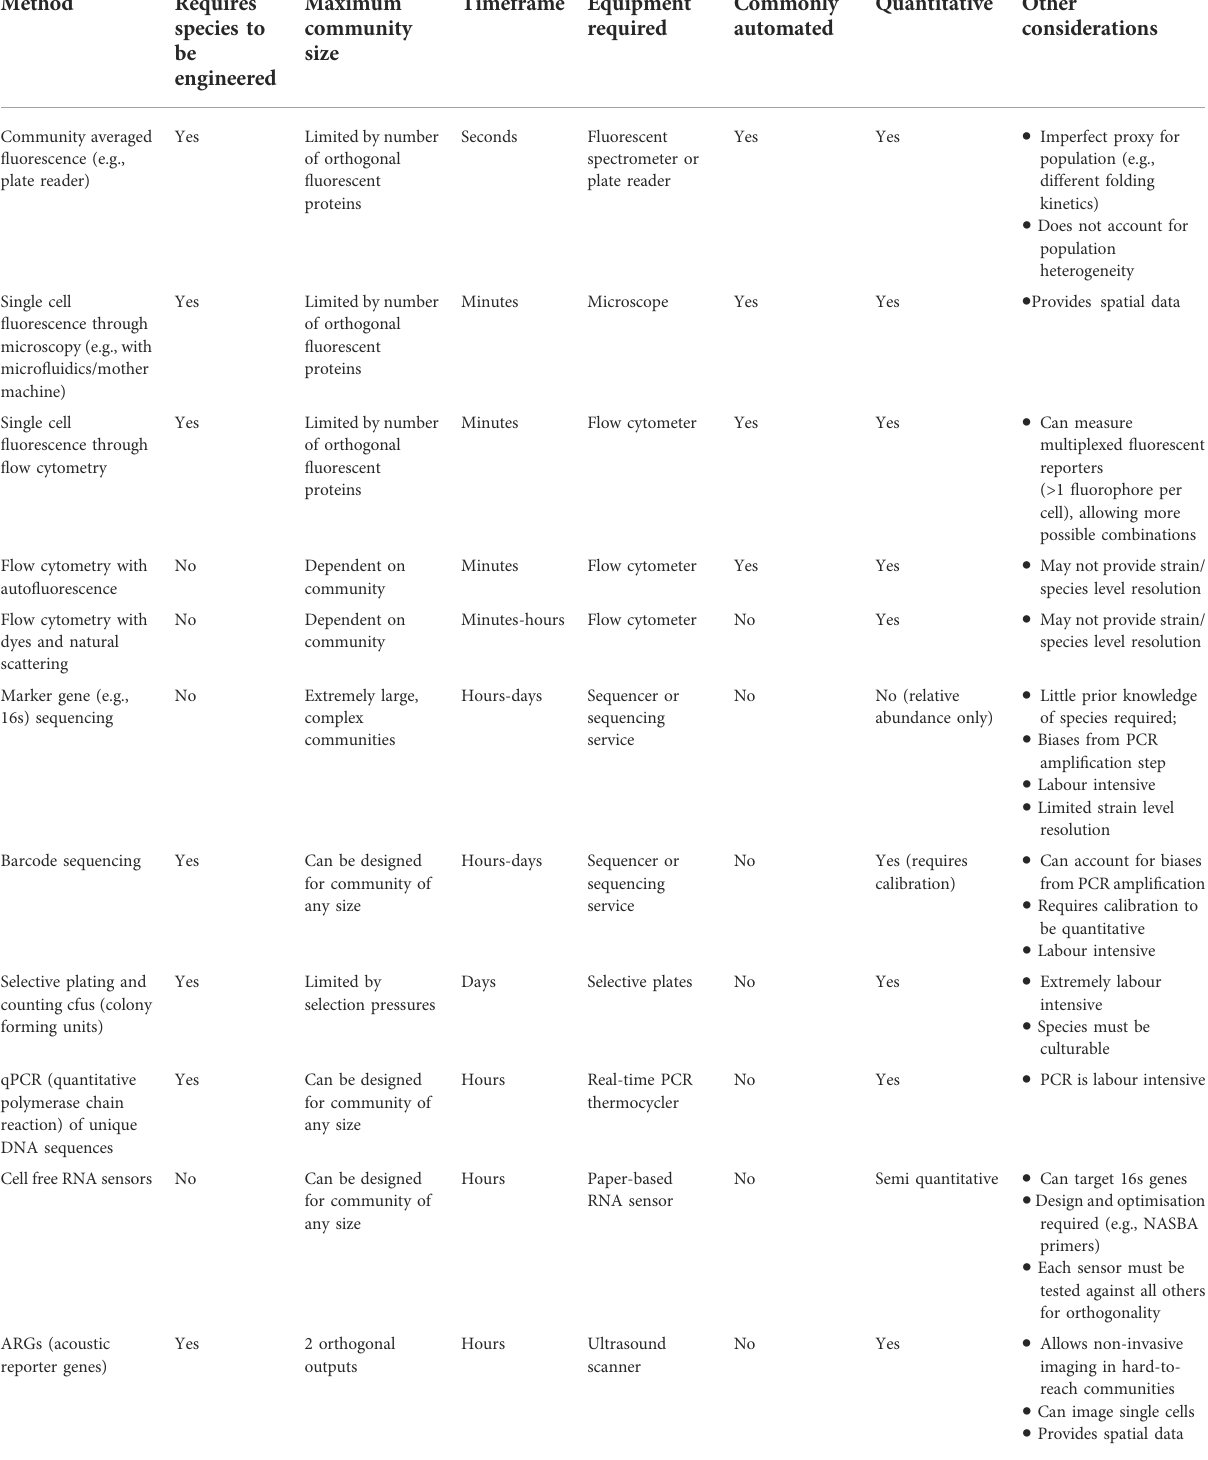
TABLE 1 Methods of measuring community composition (output) and their characteristics (i.e. factors that need to be considered when selecting a method).